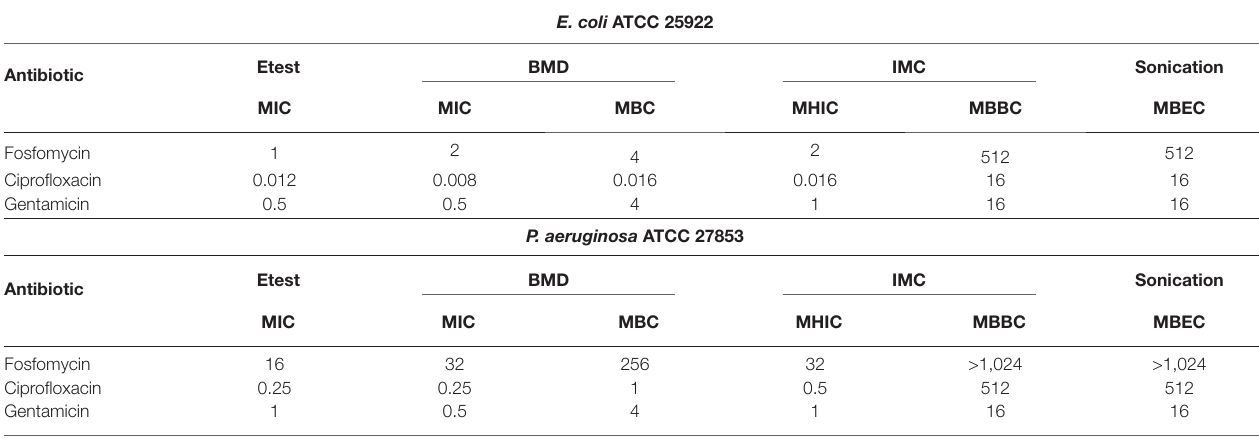
TABLE 1 | Antimicrobial susceptibility of planktonic and adherent E. coli and P. aeruginosa determined by conventional broth macrodilution (BMD), Etest, isothermal microcalorimetry (IMC), and